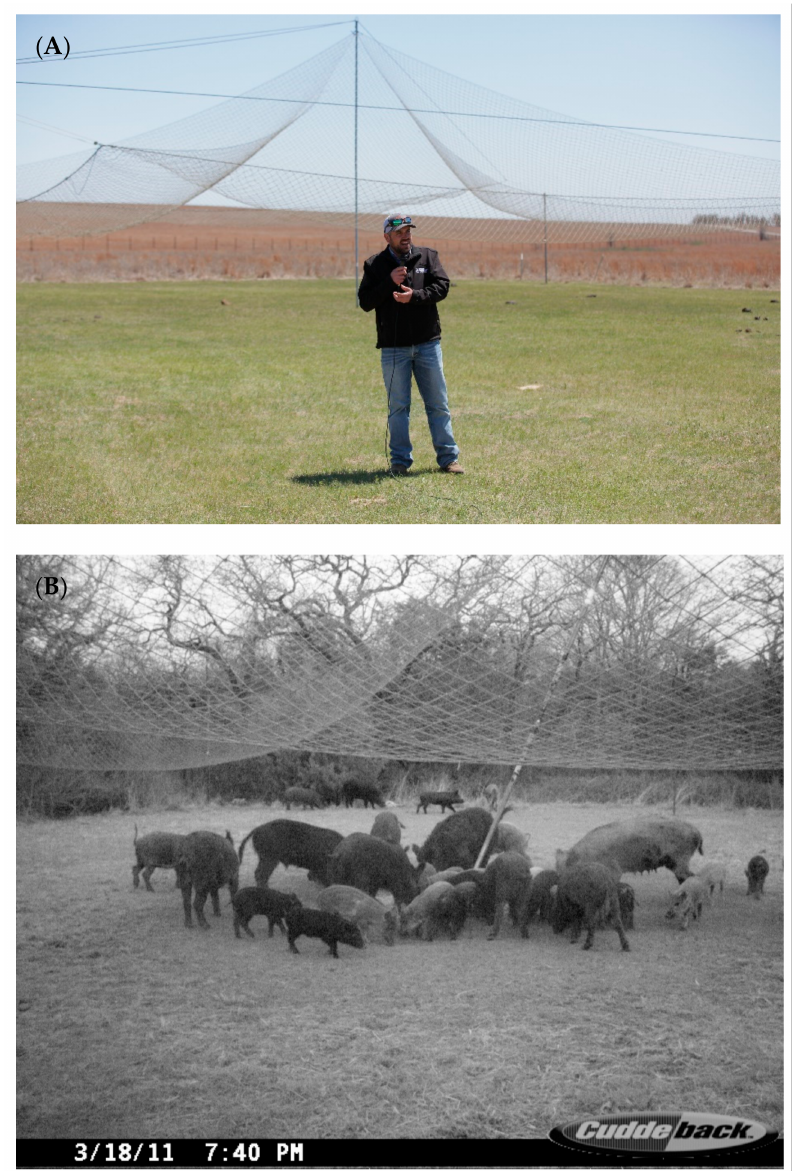
Figure 5. Wide angle view of the drop net used to capture wild pigs ( Sus scrofa ) in Love County, OK, USA ( A ). Sounder of wild pigs consuming corn under a drop net <30 min after the net was erected and baited; photograph captured with Cuddeback digital camera (Cuddeback, De Pere, WI, USA) ( B ). Photographs courtesy of Noble Research Institute, LLC (Ardmore, OK,